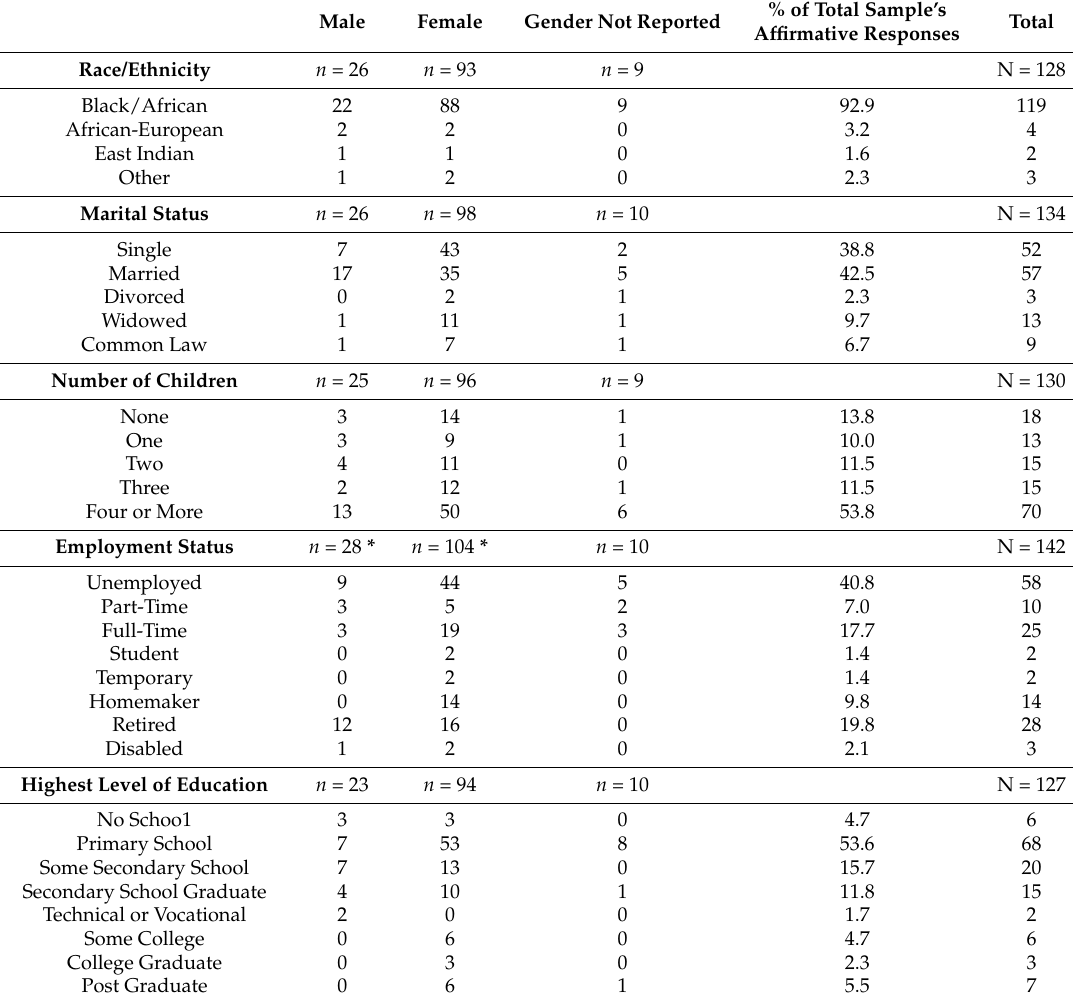
Table 1. Patient demographics and reported health